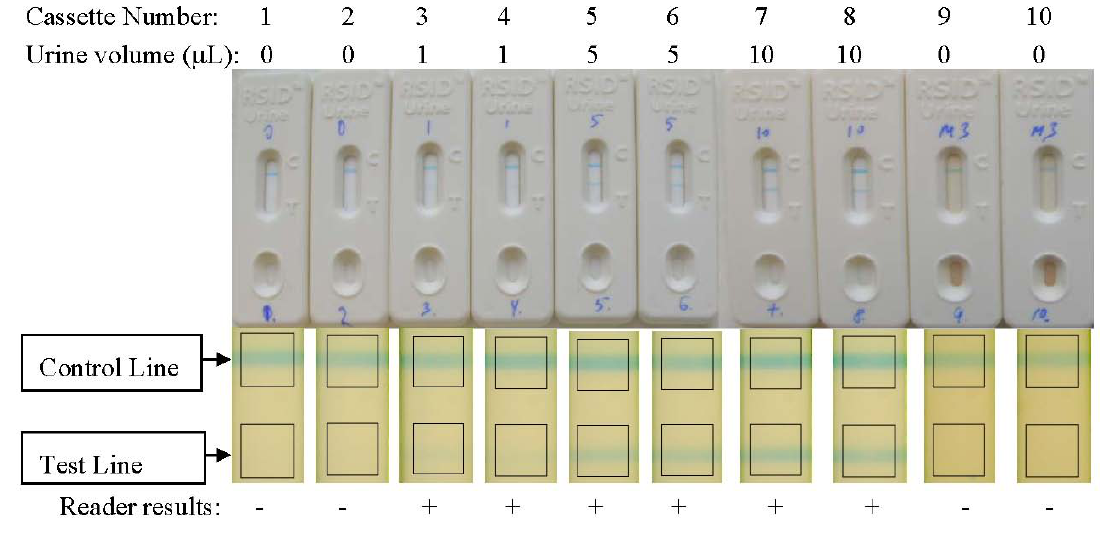
Figure 5. Results of RSID™ Urine and RSID™ Reader Experiments. Results of two replicates for each analyzed urine volume from one Reader are shown. Cassette number and calculated volume of urine added to each cassette are shown ( top ). Digital camera capture of cassettes and RSID™ Reader images are shown below,